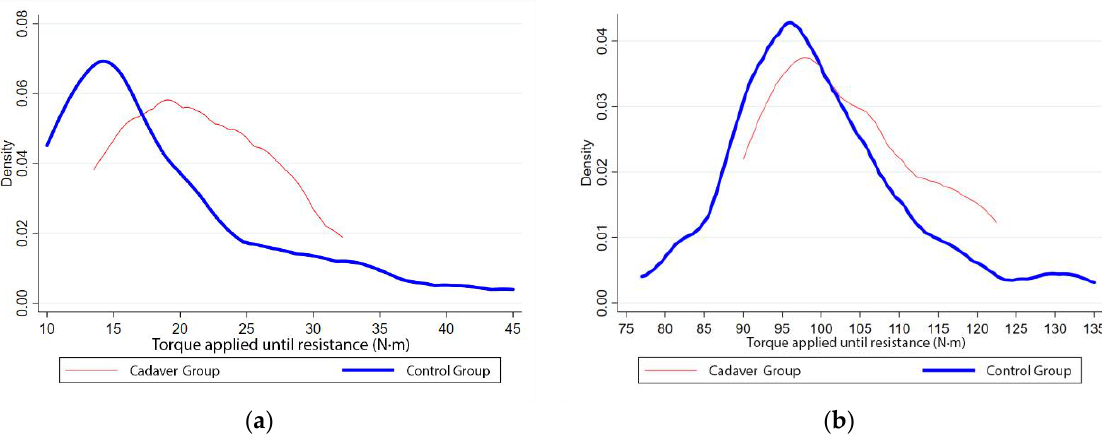
Figure 4. Continuous distribution comparing baseline measurements of the control (blue) and cadaver (red) groups in terms of the torque required to achieve maximum external rotation ( a ) and said external rotation ( b ).